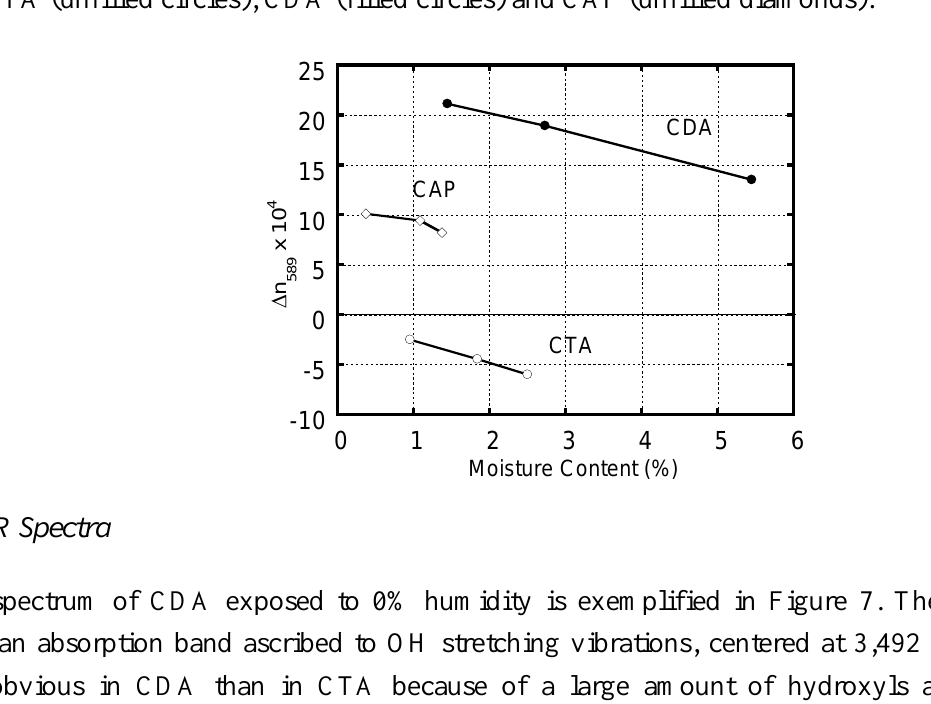
Figure 6. Relation between orientation birefringence at 589 nm and moisture content of CTA (unfilled circles), CDA (filled circles) and CAP (unfilled